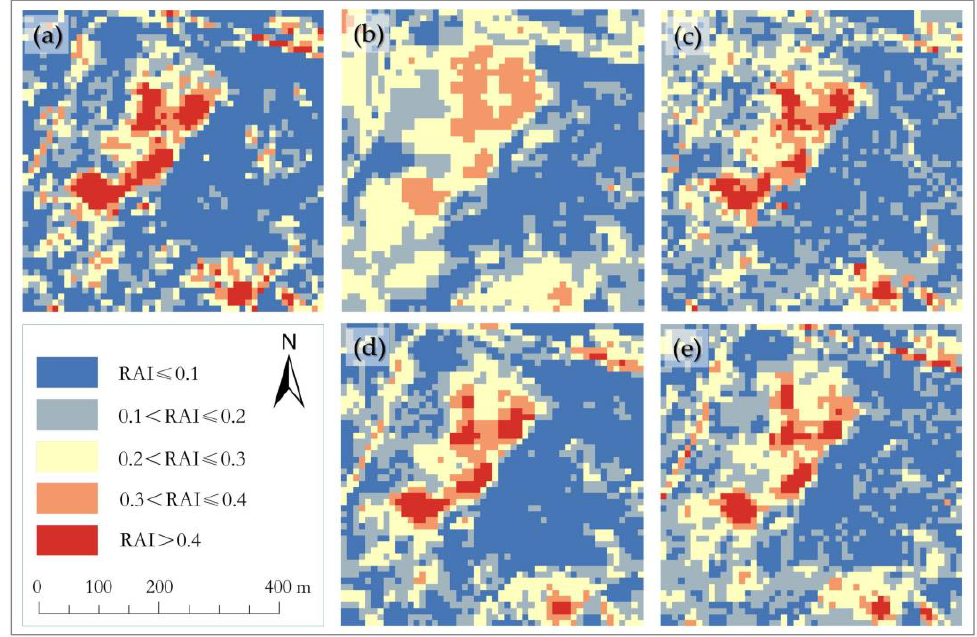
Figure 5. Calculate RAI distribution of the sample plot using: ( a ) UAV image; ( b ) the MLR model; ( c ) the MLP neural nets model; ( d ) the RF model; and ( e ) the SVR model. According to RAI ≤ 0.1 (I), 0.1 < RAI ≤ 0.2 (II), 0.2 < RAI ≤ 0.3 (III), 0.3 < RAI ≤ 0.4 (IV), and RAI > 0.4 (V), the RAI of the sample plot was divided into five levels. The area